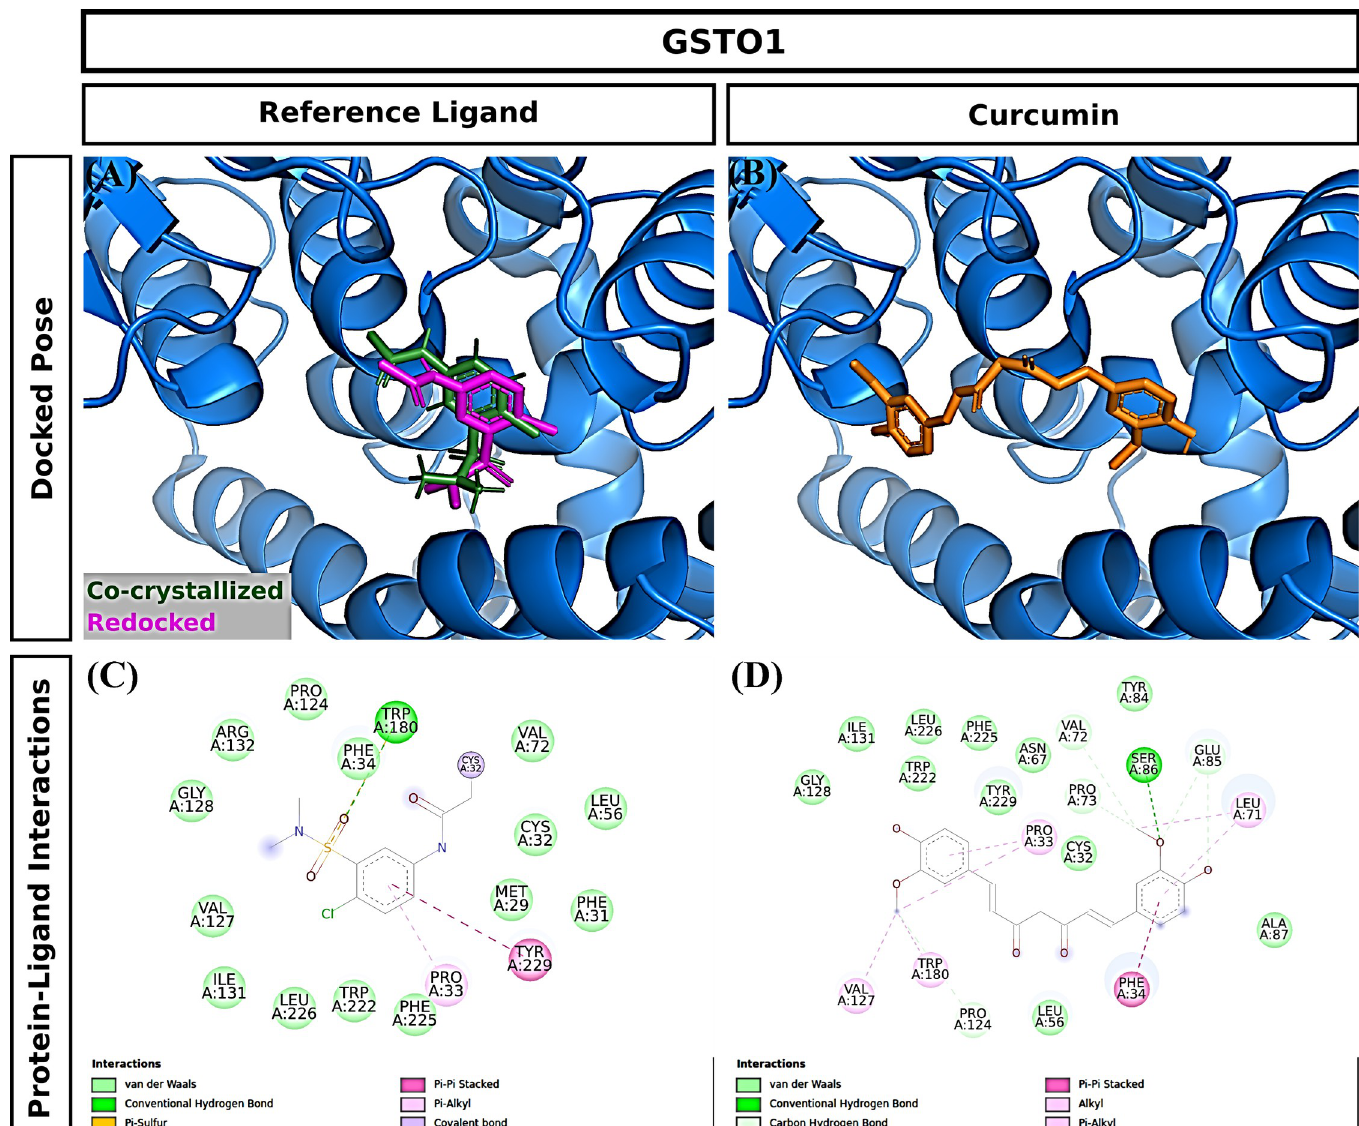
Fig 8. Molecular docking of curcumin to GSTO1. (A) Redocking of the bound ligand. (B) Docking pose of curcumin. (C) Interactions of the bound ligand with the protein. (D) Predicted interactions of curcumin with the protein.